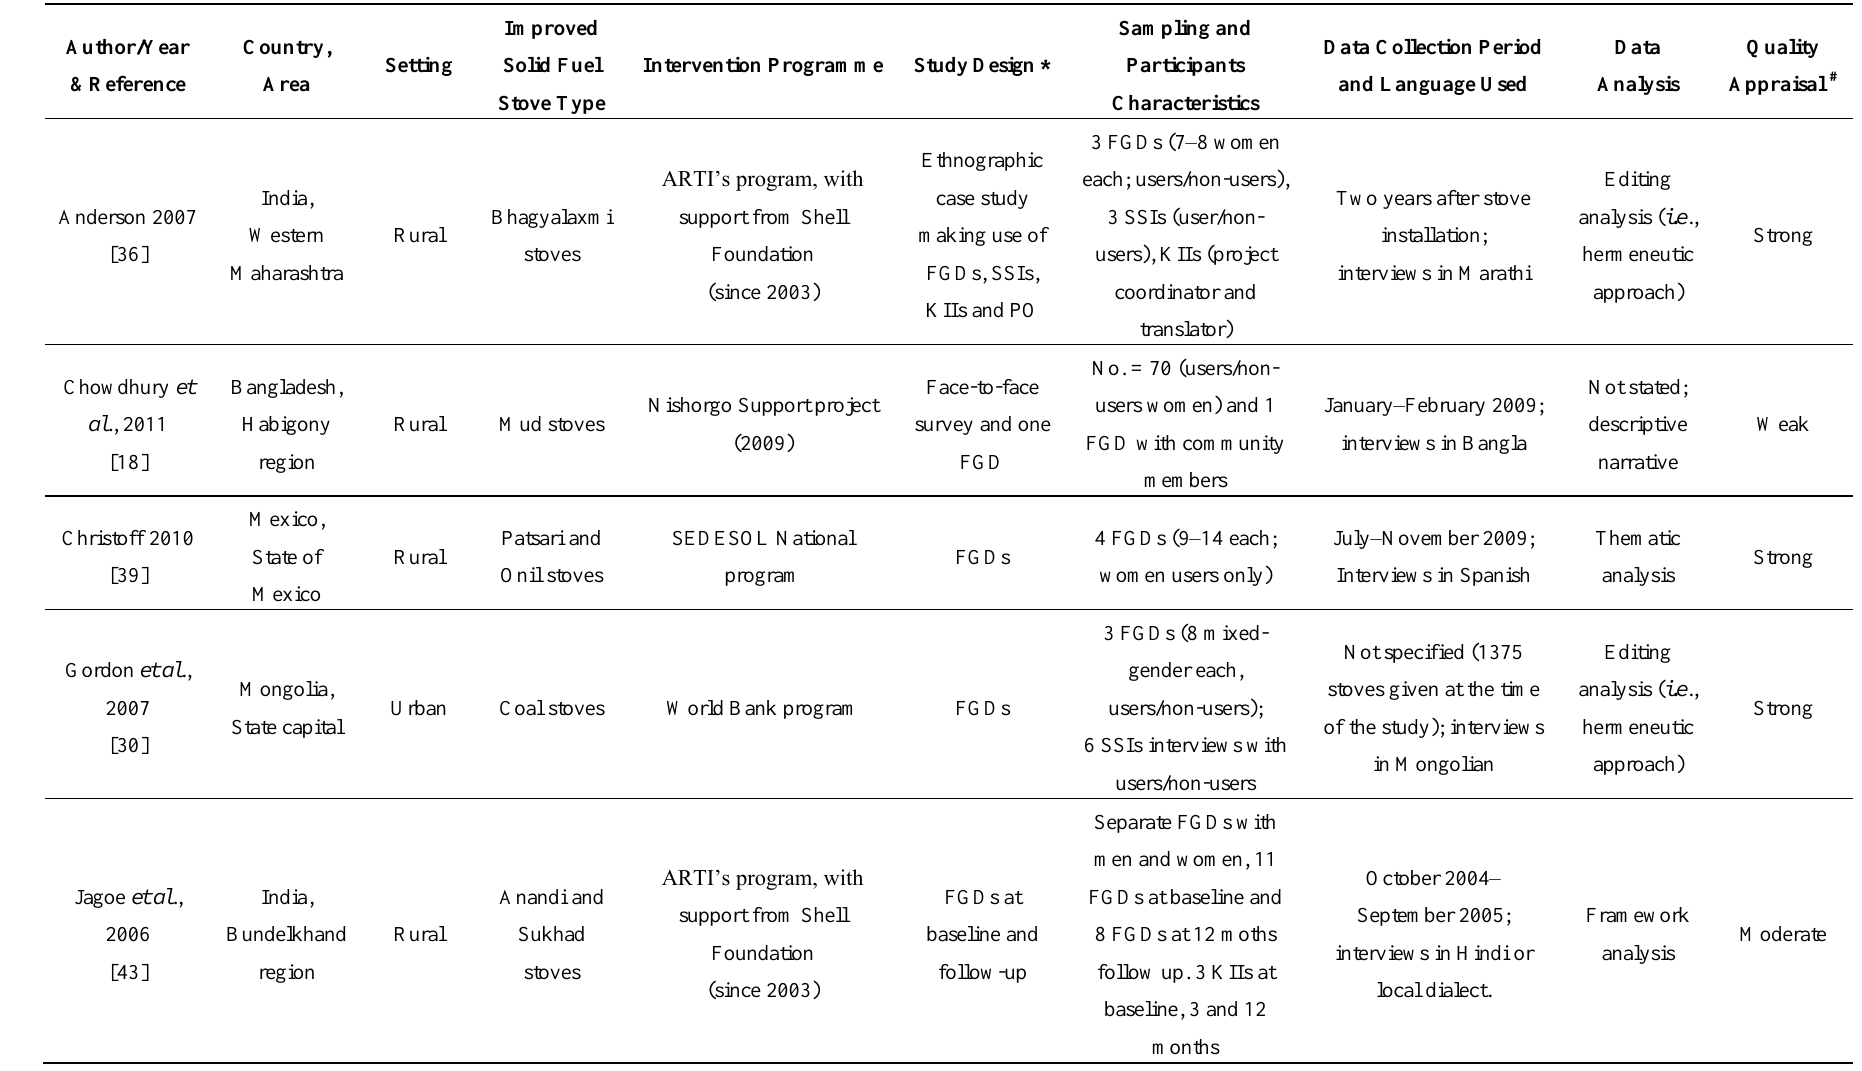
Table 2. Characteristics of included